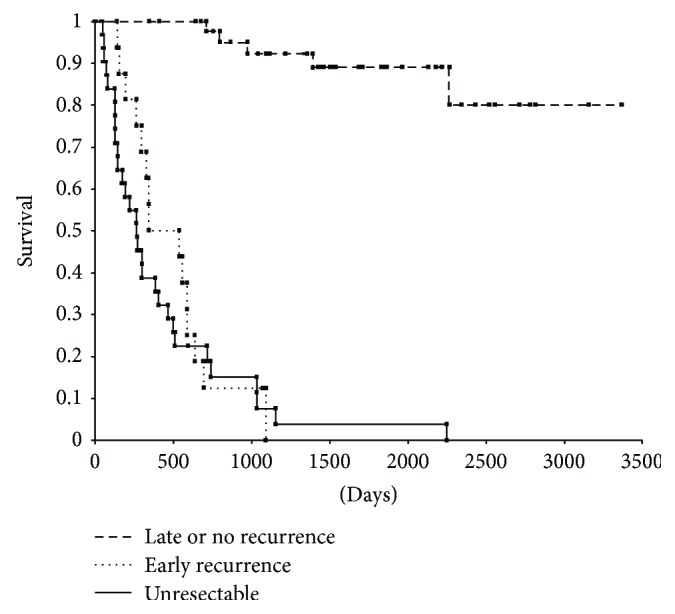
Overall survival for 3 groups (unresectable (n = 33), early recurrence (n = 16), and late and no recurrence (n = 45)).